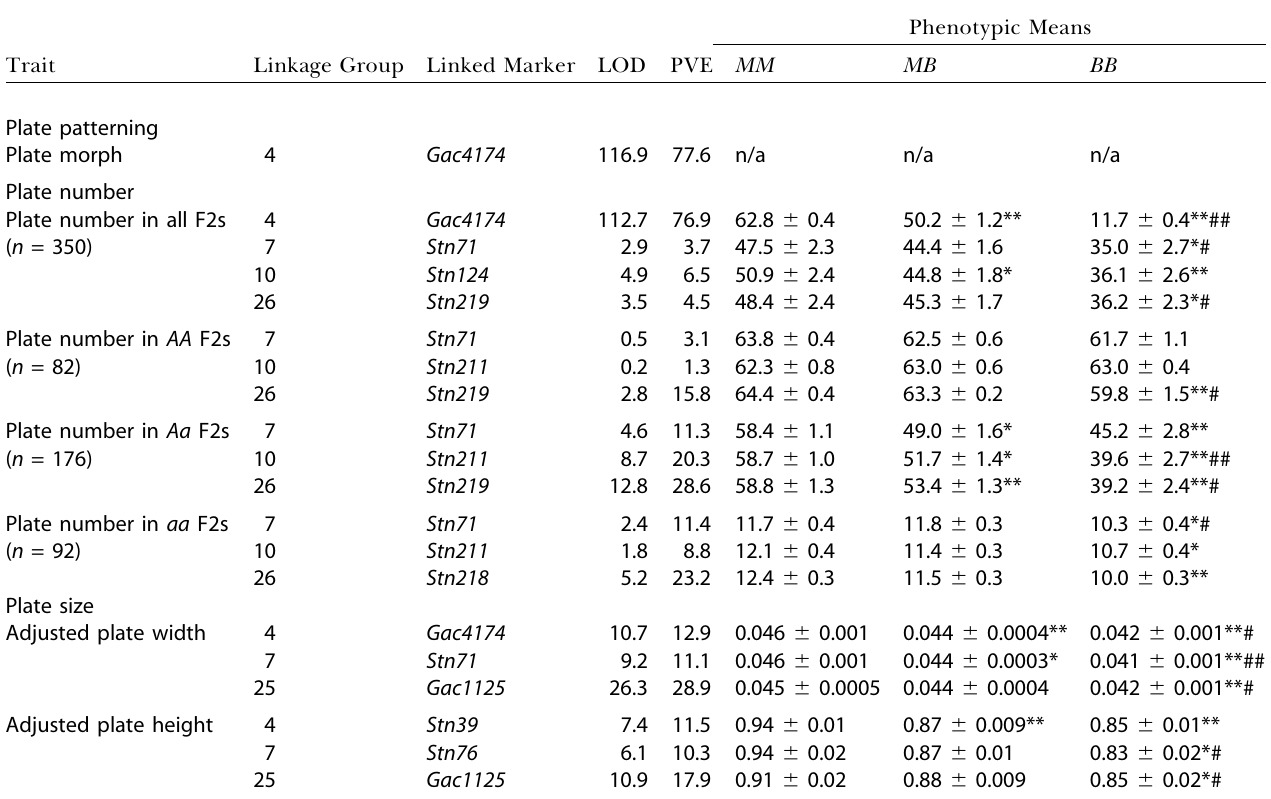
Table 1. Summary of QTL Affecting Lateral Plate Phenotypes in Cross